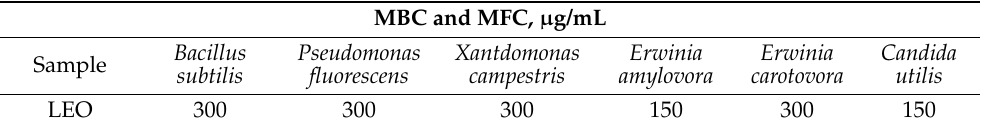
Table 5. The antimicrobial activity of lavender essential oil. MBC and MFC, µ g/mL Bacillus Pseudomonas Sample subtilis fluorescens LEO 300 150